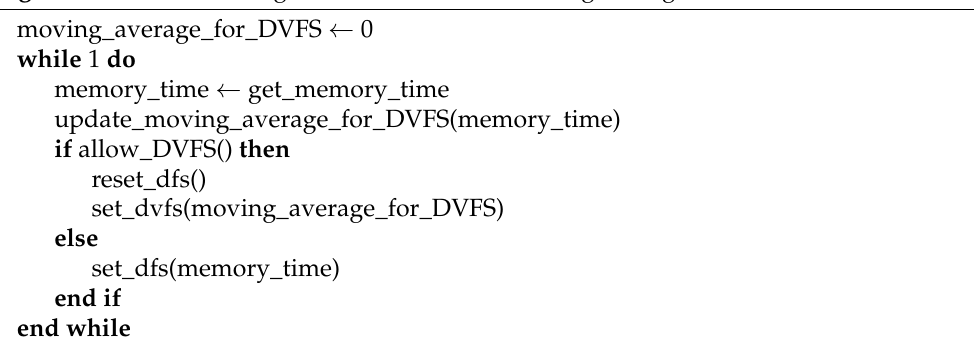
Algorithm 1 Power management firmware via moving